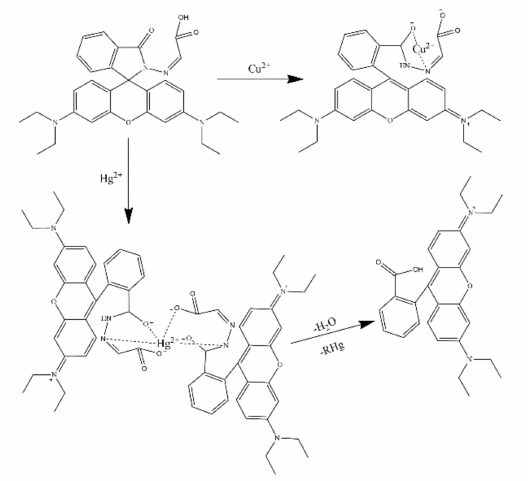
Figure 51. Proposed binding modes of the prepared sensor (Table 4, No. 2) with Cu 2+ and Hg 2+ [107]. RHB (Table 4, No. 3) was a reusable spherical solid supported sensor prepared by a simple two-step route. (1) synthesis of aldehyde functional spherical crosslinked poly(vinylbenzaldehyde-co-divinylbenzene) microbeads (PVBA-DVB) via precipitation polymerization and (2) attaching the rhodamine hydrazide to aldehyde groups via imine linkages [108]. The prepared RHB sensor displayed selective turn-on fluorescence and colorimetric response to Cu 2+ and Hg 2+ (Figure 52).